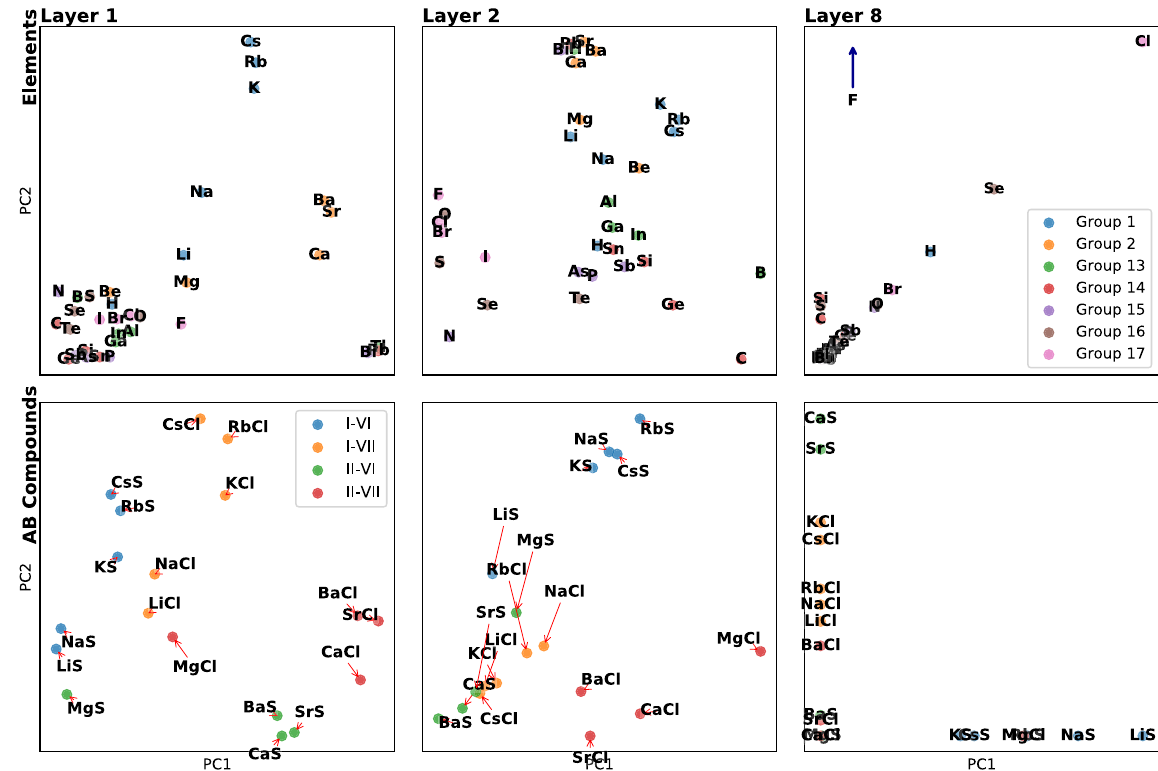
Figure 6. Visualization of the activations of different materials in ElemNet . Each frame shows a 2D projection (using PCA) of the activations of different materials in several layers of ElemNet , which shows which materials have similar representations. The upper row shows the activations of different elements, where each point is a different element and is colored by the group number. The second row shows the activations of AB compounds formed of group I and II metals combined with S (group VI) or Cl (group VII). We note that elements from the same group in the periodic table, such as alkali metals, are clustered together in the early layers of the network, and that later layers reflect properties related to combinations of elements (e.g., charge